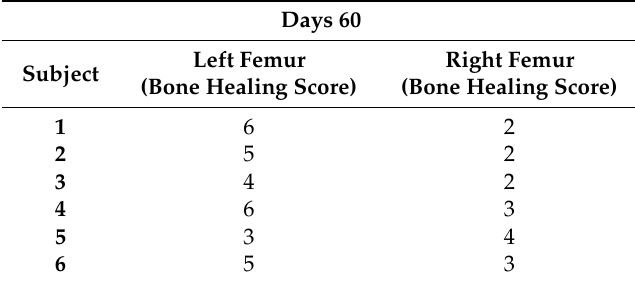
Table 4. Bone healing scores for bioactive glasses implanted in rabbits’ left and right femurs. (see Table 2 for the list of materials).